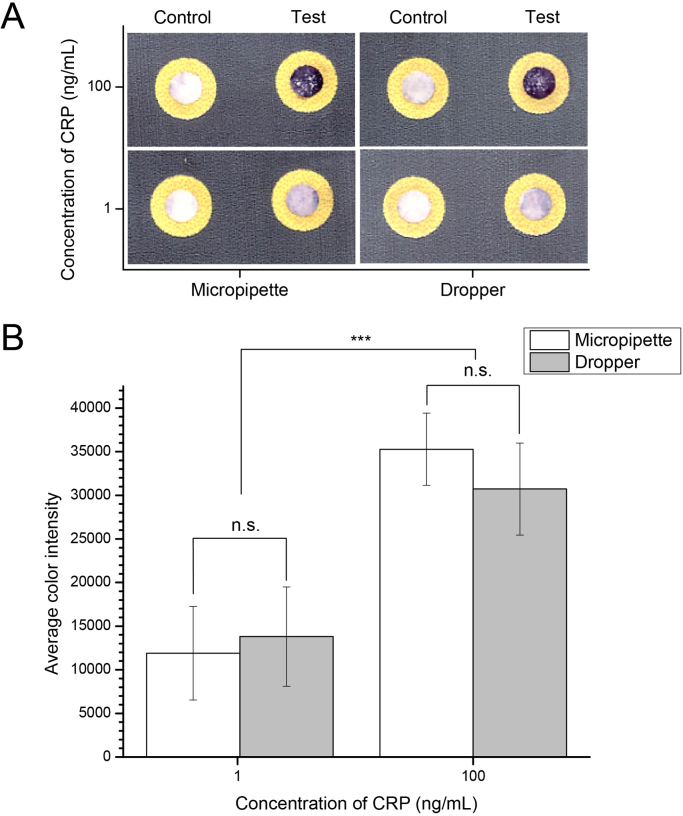
Comparison of the use of a micropipette and a dropper for assaying C-reactive protein (CRP) using a sliding-strip 3D µPAD. A) Representative images of the results. B) Response of the device as measured by the average color intensity. Average color intensity was calculated in the same way as in Fig. 2. The column plot represents mean±S.D. (n = 6), n.s.: not significant (p>0.1), *** (p<0.001).